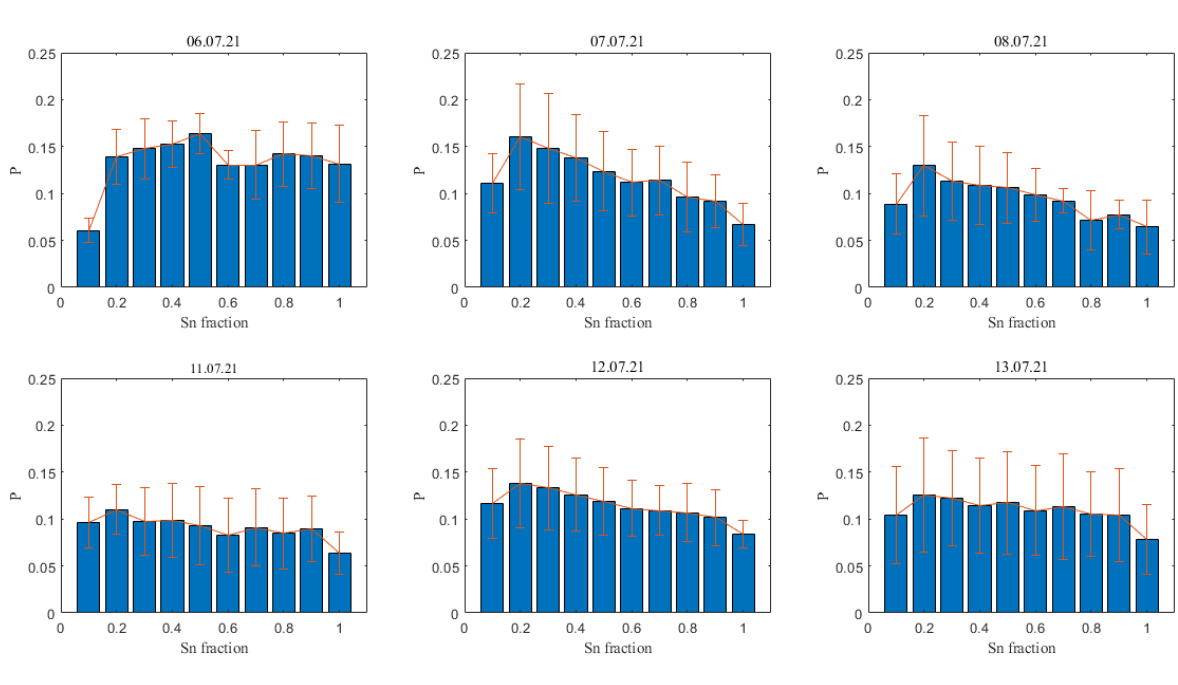
Figure 8. The effect of Solanium nigrum fraction (F) in the pixel on misclassification probability (P) on 6 days of measurements. The mean was calculated based on 5 different sowing plates. Error bars represent the probabilities’ standard